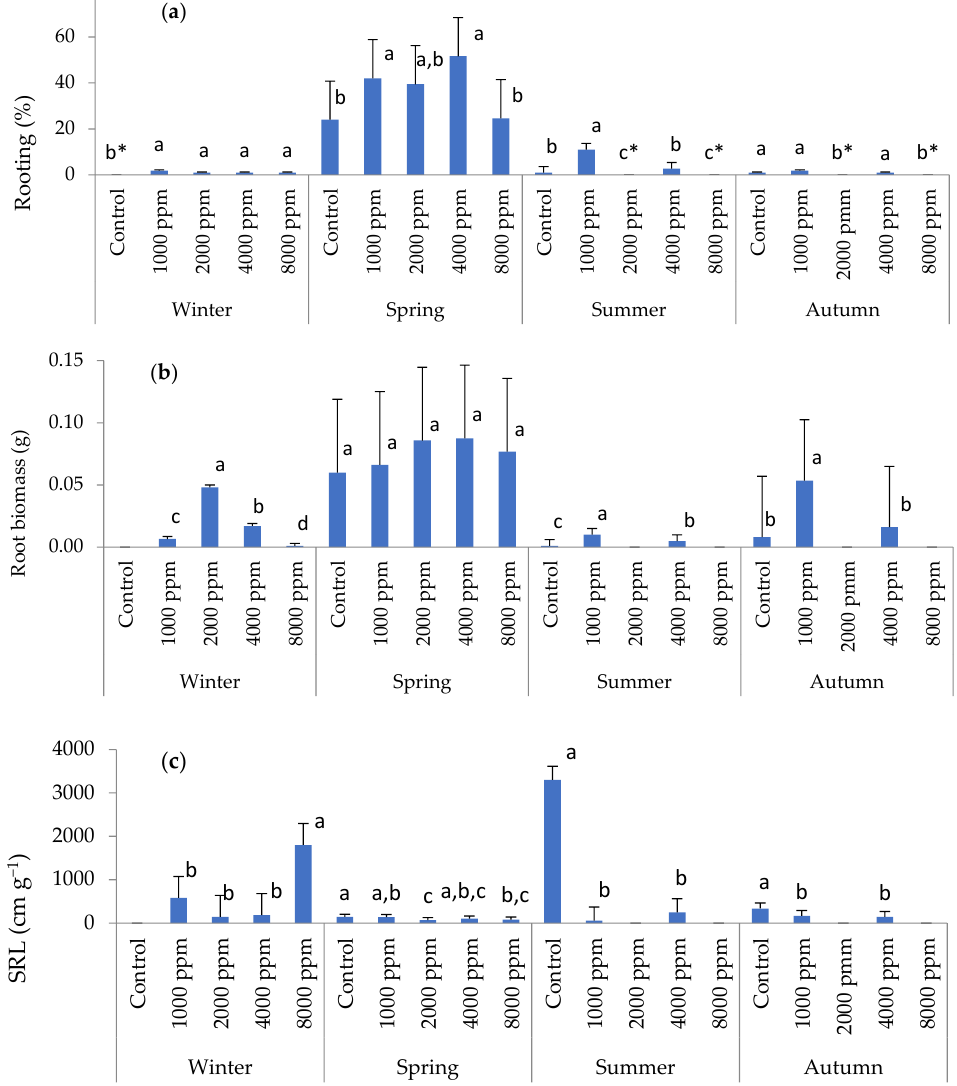
Figure 3. Mean values of rooting performance in rooted cuttings within seasons and with five indole butyric acid (IBA) pretreatments: ( a ) % of rooting, ( b ) root biomass, and ( c ) SRL. Mean values with the same letter do not differ at 0.05 level according to LSD test. Sample data = 540 cuttings in each season. Treatments in which all cuttings dried are not represented in the figure. Error bars: LSD intervals. * Rooting percentage was zero.